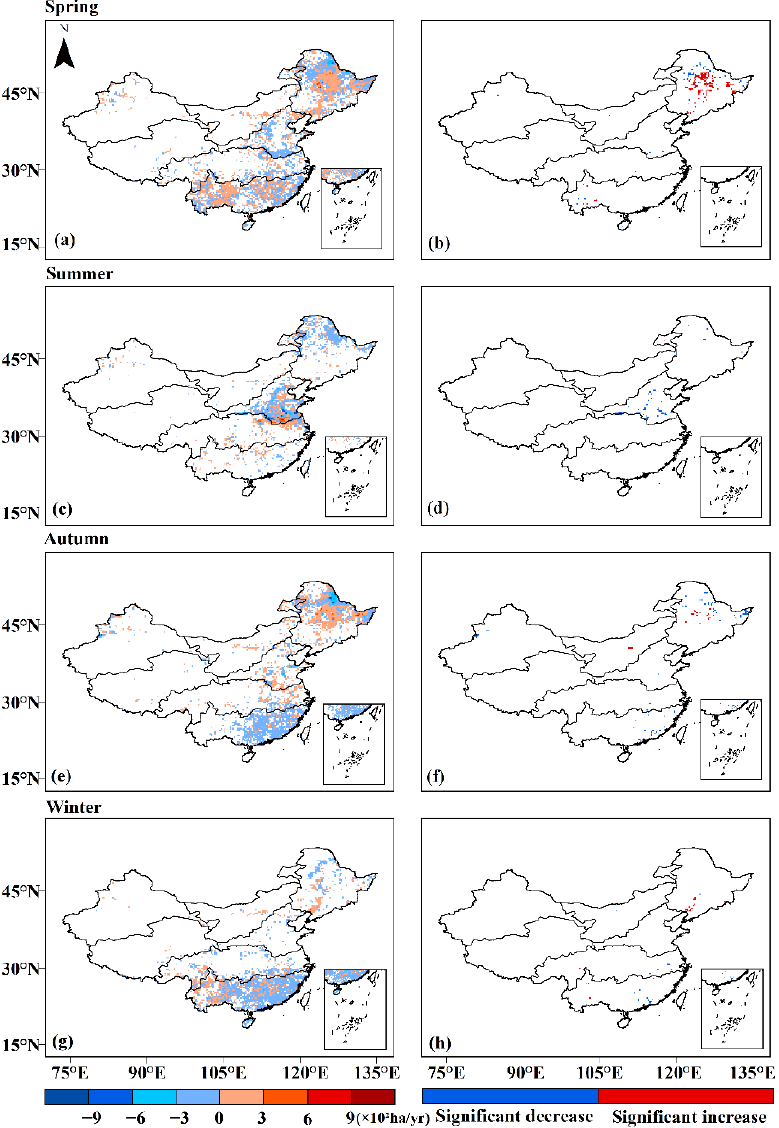
Figure 10. Spatial distribution of seasonal BA trends. The left columns are the trends of all points, and the right columns are the trends of the corresponding points passing the significance test ( p < 0.1): ( a , b ) in spring; ( c , d ) in summer; ( e , f ) in autumn; ( g , h ) in winter.